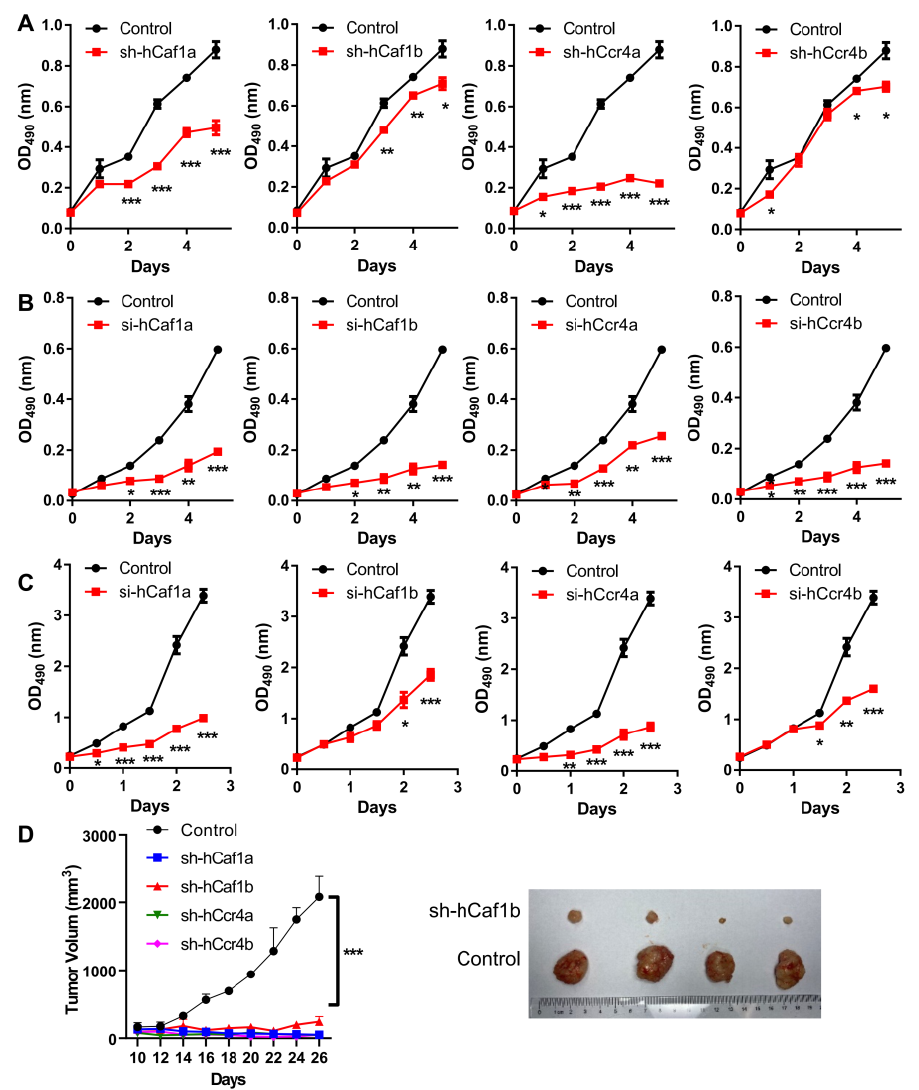
Figure 2. Depletion of hCcr4a/b or hCaf1a/b inhibits cell proliferation and tumorigenicity. ( A ) Growth curves of the stable knocking down MKN28 cells determined by the MTS assay ( n = 4); ( B ) Growth curves of the AGS cells with knockdown of deadenylases by siRNA determined by the MTS assay ( n = 3); ( C ) Growth curves of the HeLa cells with knockdown of deadenylases by siRNA determined by the MTS assay ( n = 3); ( D ) Tumorigenicity of the MKN28 cells evaluated by the nude mice model. The left panel shows the time-course changes in tumor volume, while the right panel shows the photograph of excised xenografted tumors after inoculation for 2 months ( n = 4). The xenografts of hCaf1a, hCcr4a, and hCcr4b did not result in tumors after inoculation for 2 months (also refer to Figure S6), and therefore only the control and sh-hCaf1b groups are presented. * p < 0.05, ** p < 0.01, and *** p <